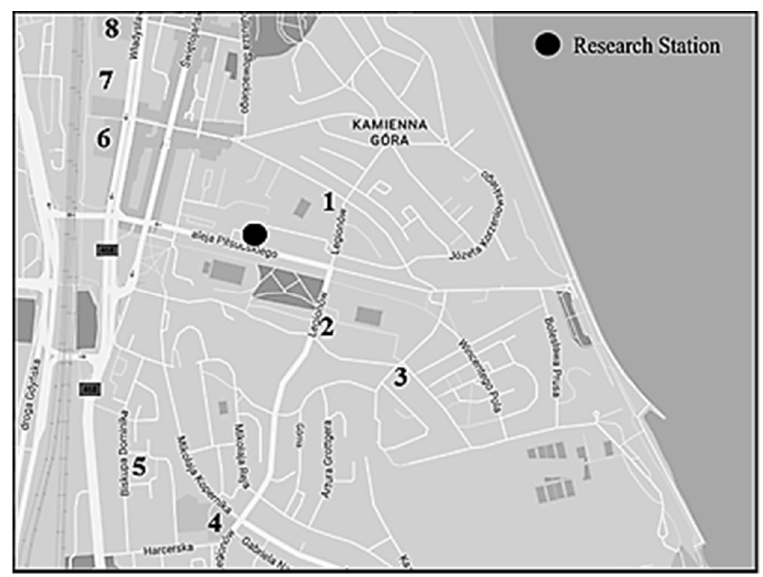
Figure 2. Location of the measuring station along with the surrounding schools.